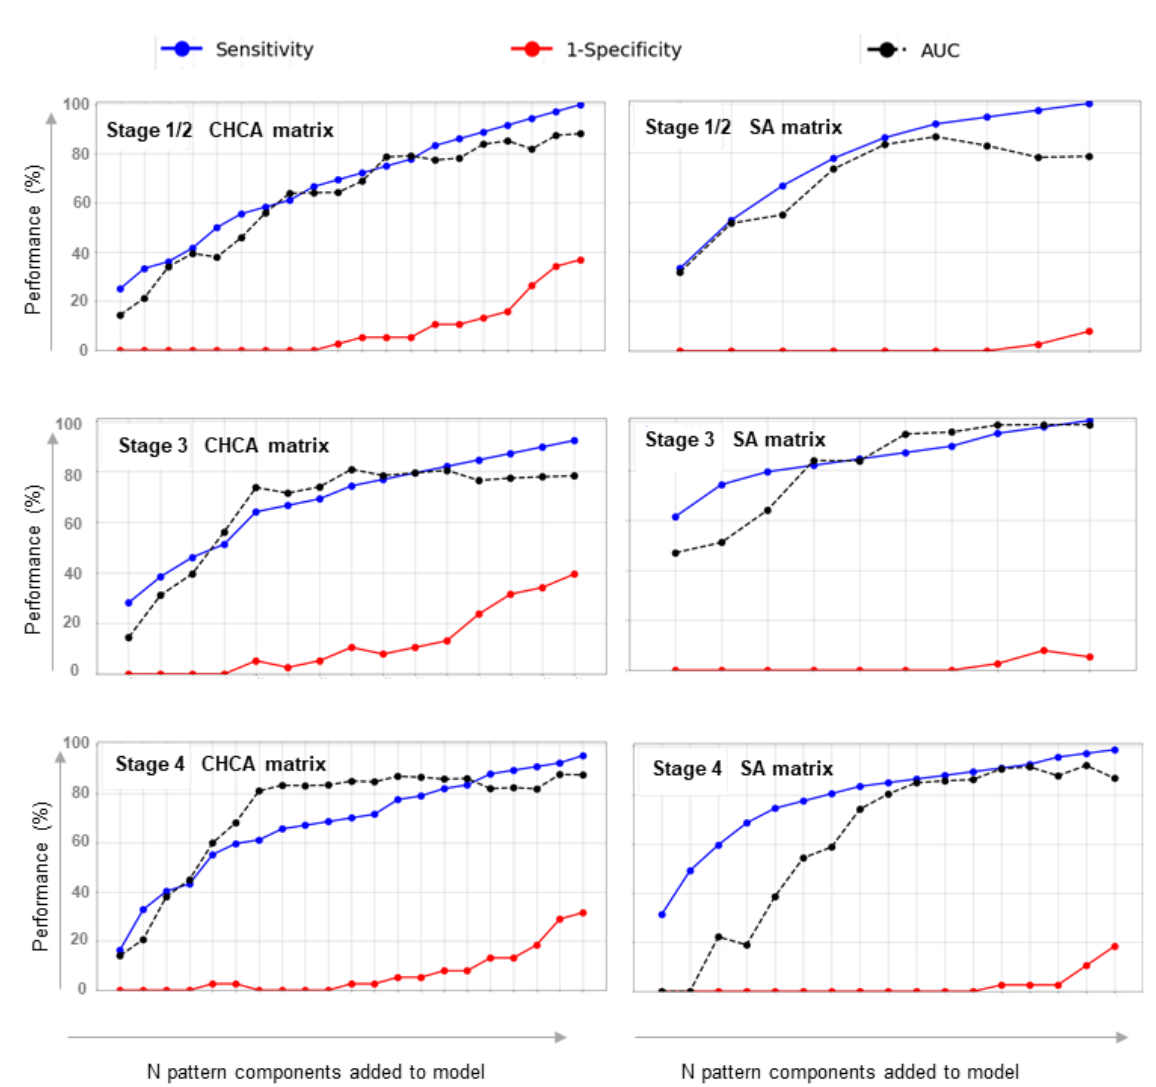
Figure 4. Performance evolution of predictive models for ovarian cancer stage classification. Each panel corresponds to an algorithm learning mass spectral signatures for a particular cancer stage using a given matrix type (indicated within a panel). Identification of peak signature combinations was performed by the EvA-3 algorithm, which selectively adds a mass spectral feature, updates the performance, and chooses the next best combination until further performance optimization is no longer possible. The algorithm starts with the best detected single signature (N) and each subsequent point is an N+1 combination of signatures. Dots indicate the computed values for each combination and respective performance indicators. Sensitivity evolution is depicted in blue lines, specificity in red lines, and the area under the curve of the computed ROC (AUC) in black dashed lines.